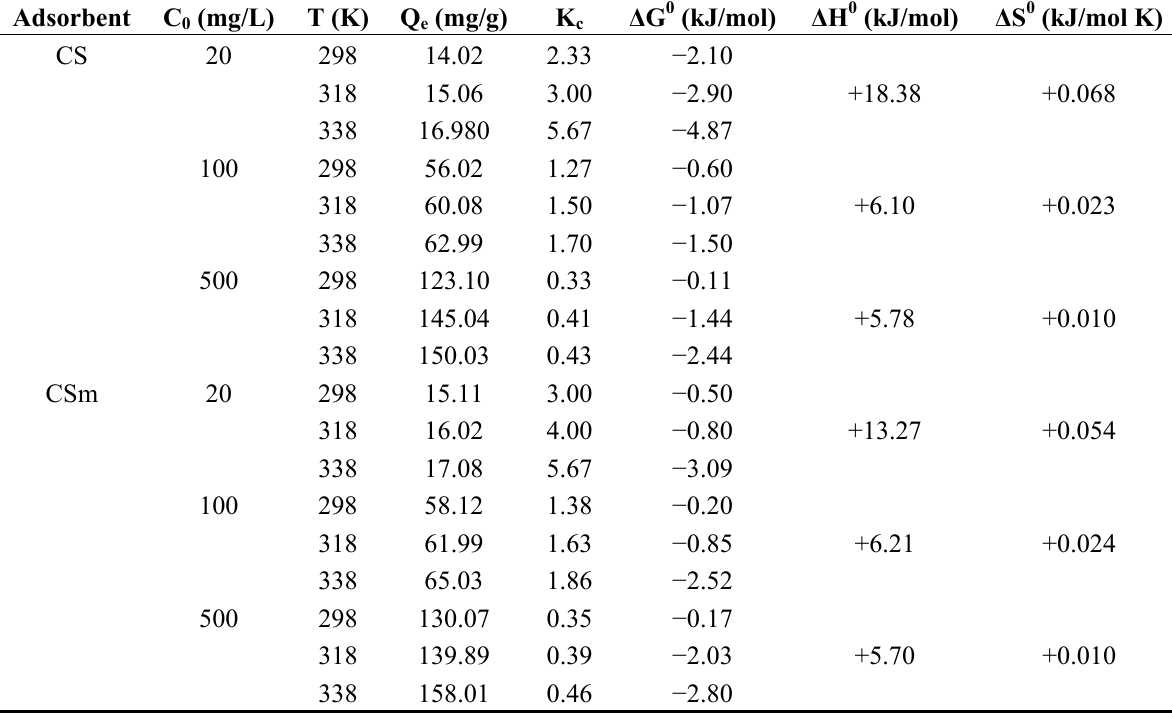
Table 4. Thermodynamic parameters for the adsorption of Hg(II) onto CS and CSm.